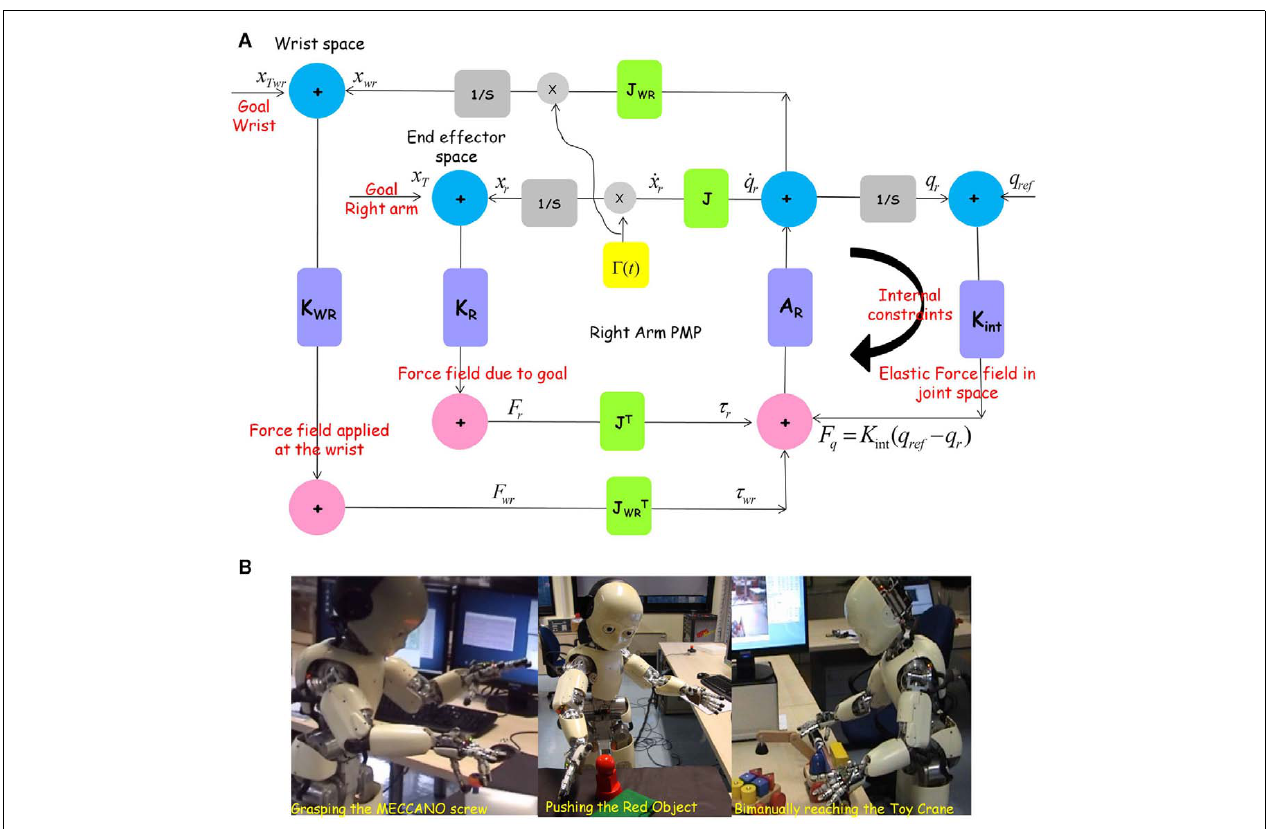
that the same timing signal synchronizes all three relaxation processes, hence allowing the hand to reach the target with a specific pose and posture. (B) Show three examples of iCub performing manipulation tasks driven by the composite PMP net of (A) . In the case of bimanually reaching the crane toy, a similar network also applies to the left arm PMP chain. Note that in all these cases, reaching the goal object with specified hand pose is obligatory for successful realization of the